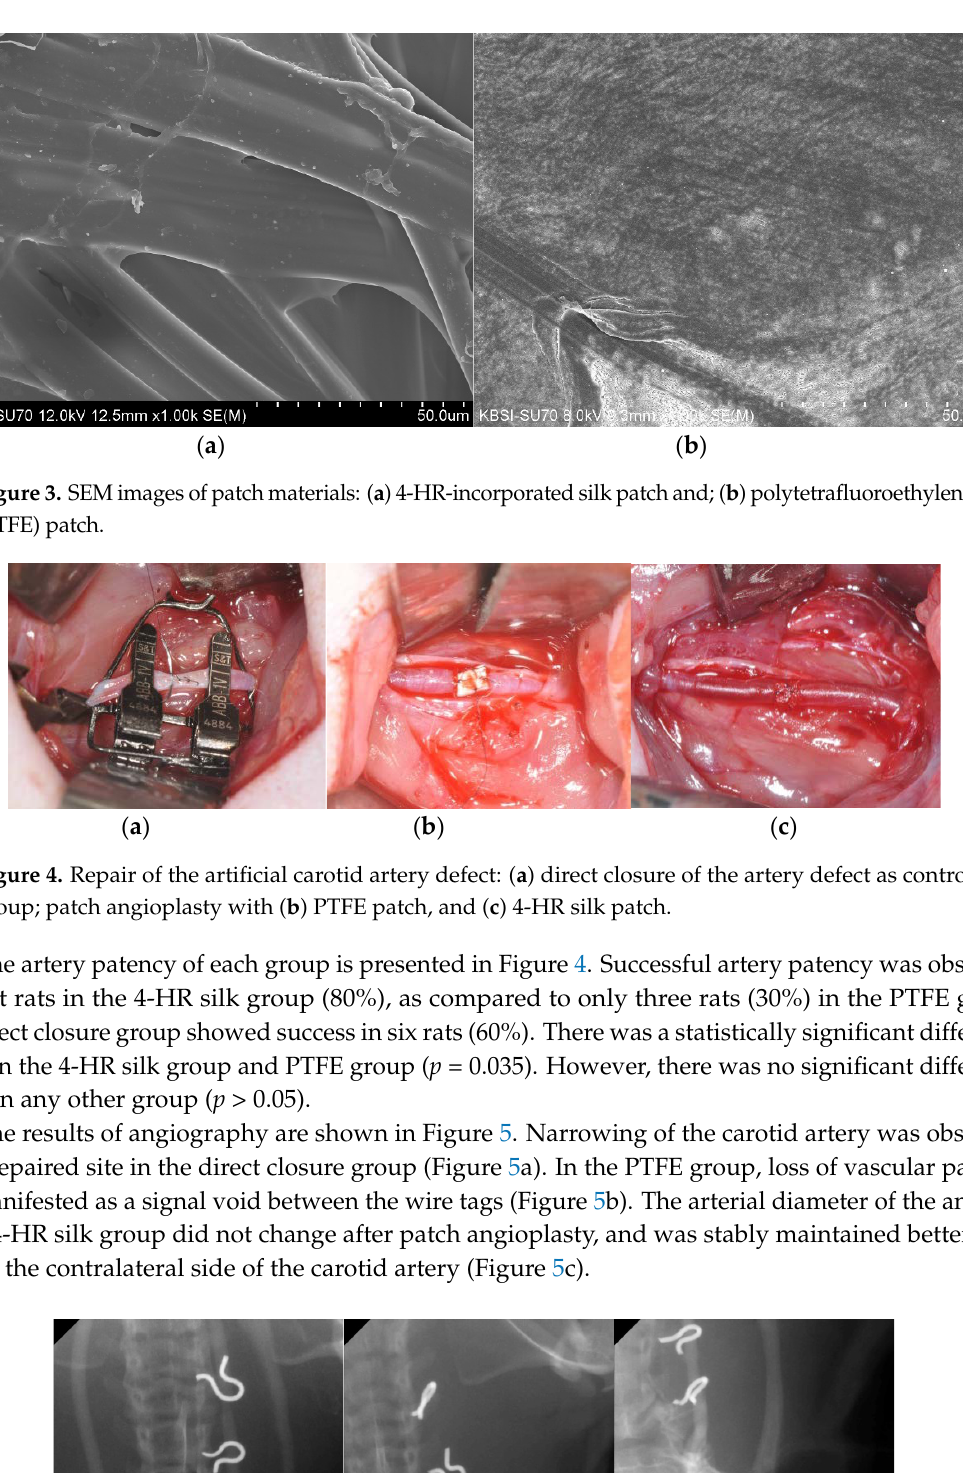
Figure 5. Three-week post-operation angiography: ( a ) direct closure as the control group; ( b ) PTFE patch angioplasty; ( c ) 4-HR silk patch angioplasty.